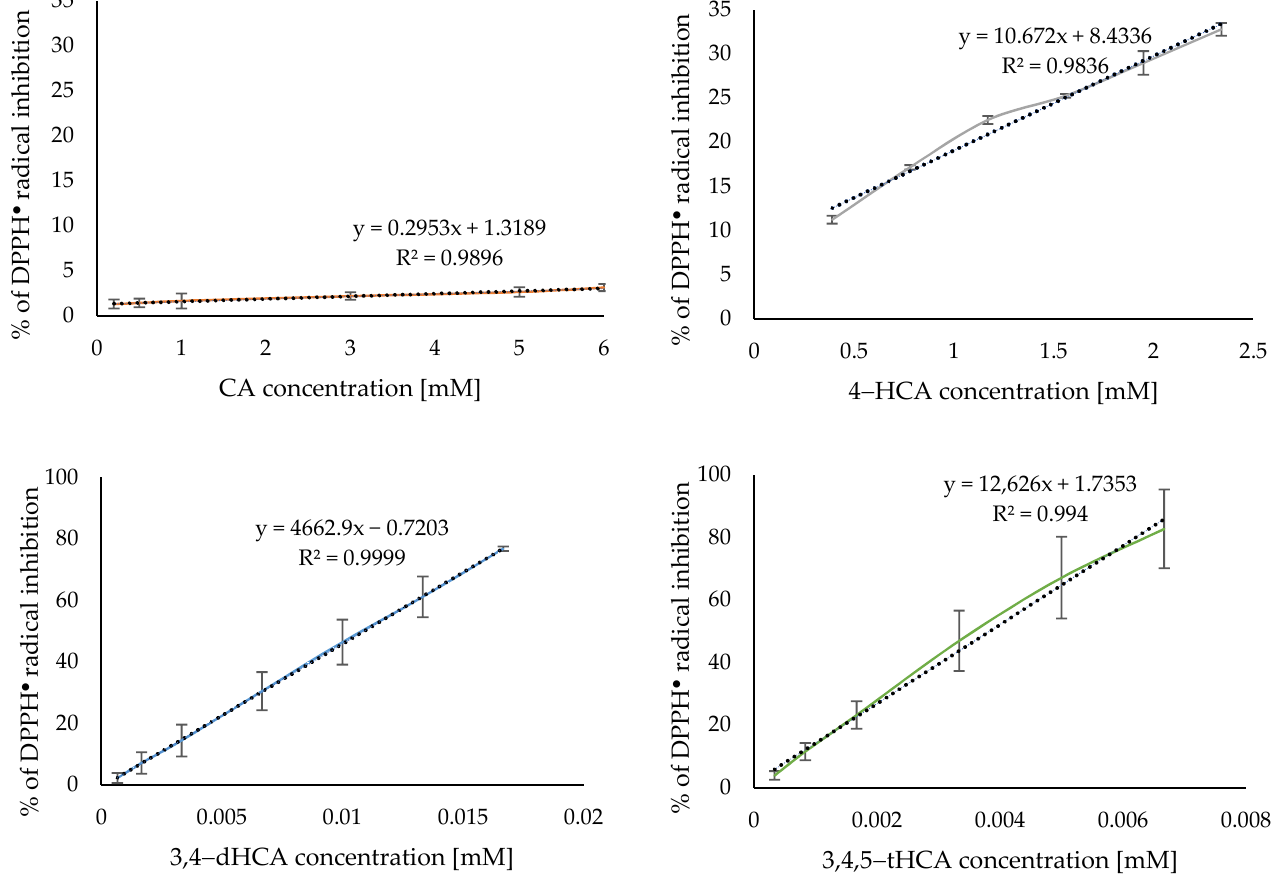
Figure 7. Antiradical activity of CA and its derivatives based on the DPPH ● radical assay. CA and its derivatives in a similar way scavenged the HO • radical (Figure 8). The results showed that % of inhibition of HO • radical was in the range: 48.40 ± 0.83%–53.02 ± 0.80%.